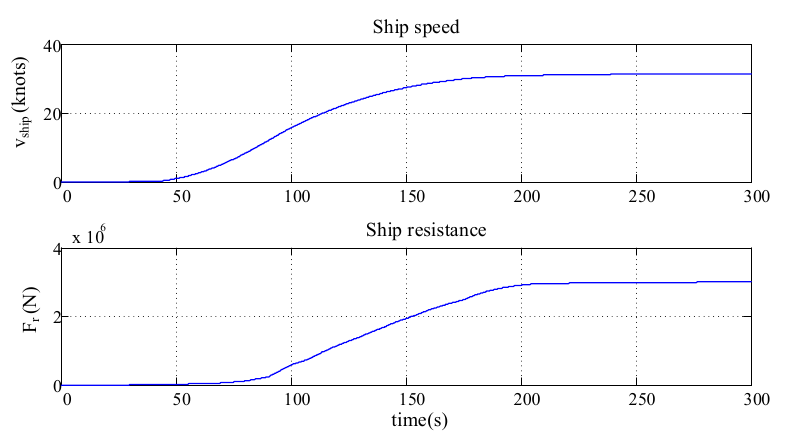
Figure 9. Case 1 ship speed and resistance.